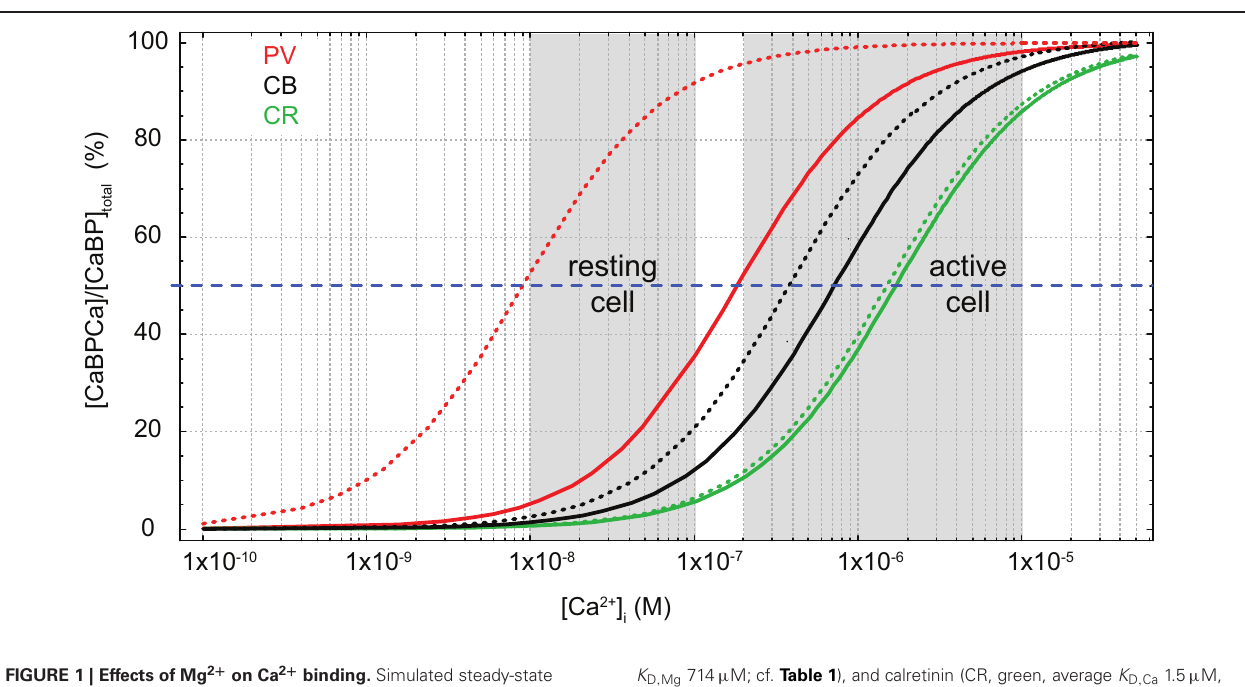
FIGURE 1 | Effects of Mg 2 + on Ca 2 + binding. Simulated steady-state Ca 2 + -binding curves of the Ca 2 + binding proteins (CaBP) parvalbumin (PV, red, K D , Ca 9nM, K D , Mg 31 µ M), calbindin (CB, black, average K D , Ca 393nM,